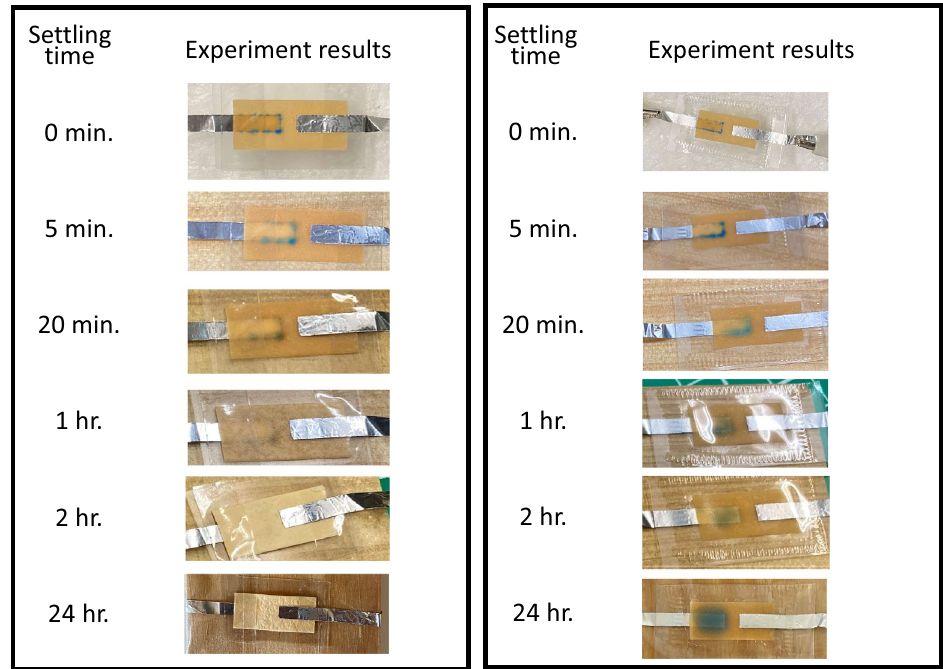
Figure 10. Color retention time of the proposed color-change RFID tag with the nonlaminated/laminated Q/ GHSC 1571–2009 pH-indicating paper.